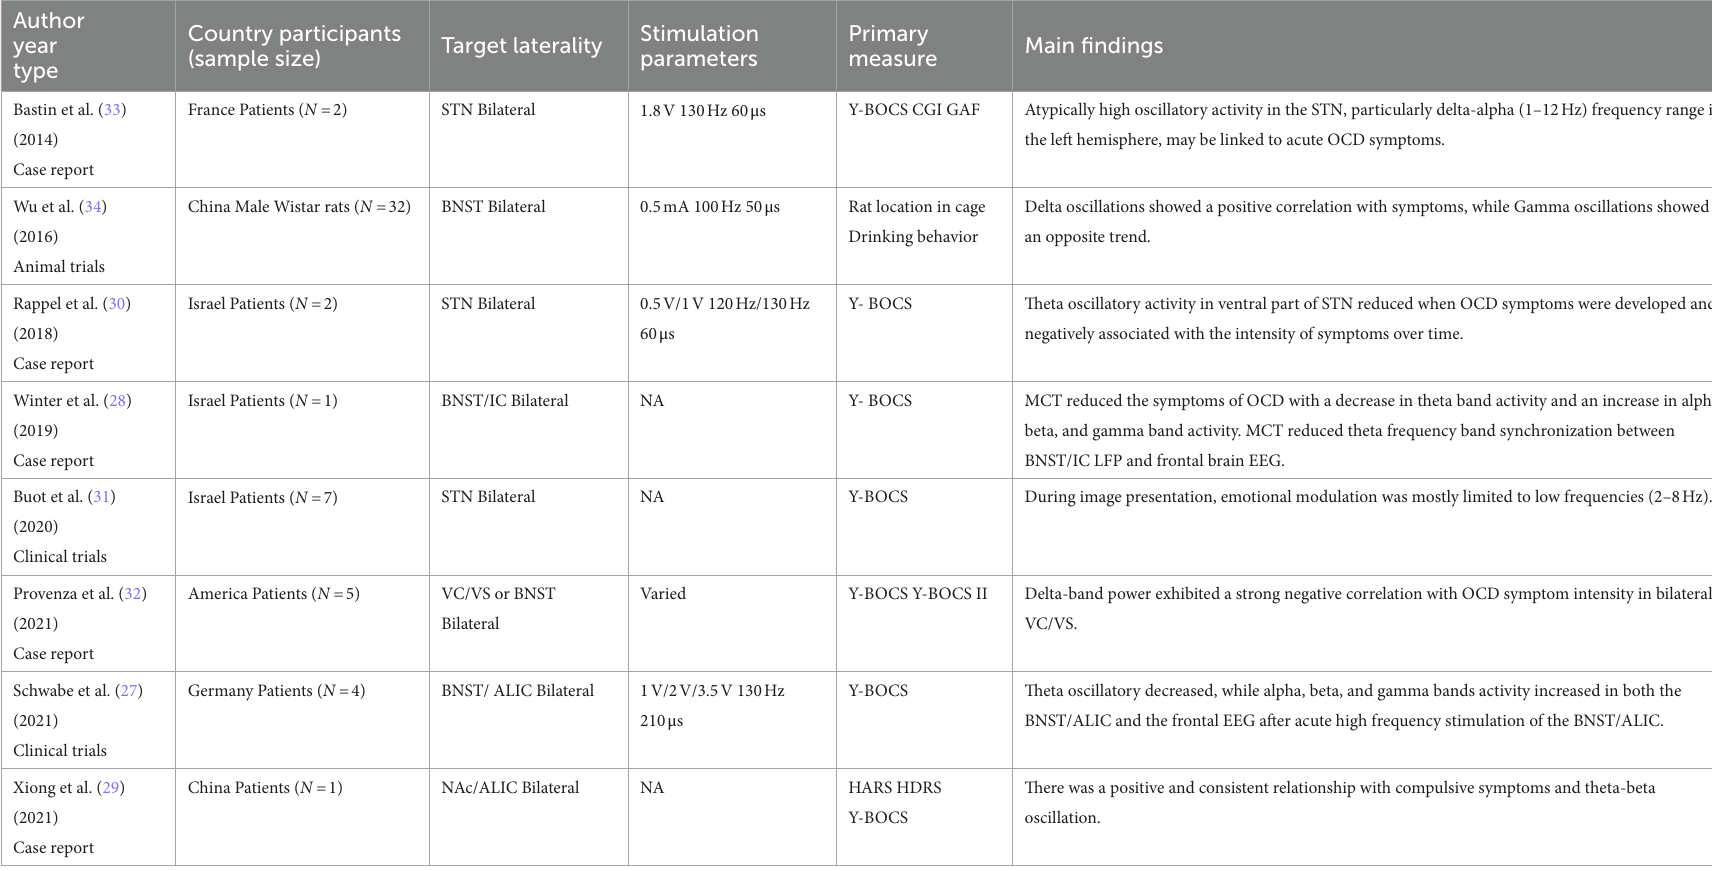
TABLE 1 Summary of recent studies on LFPs of